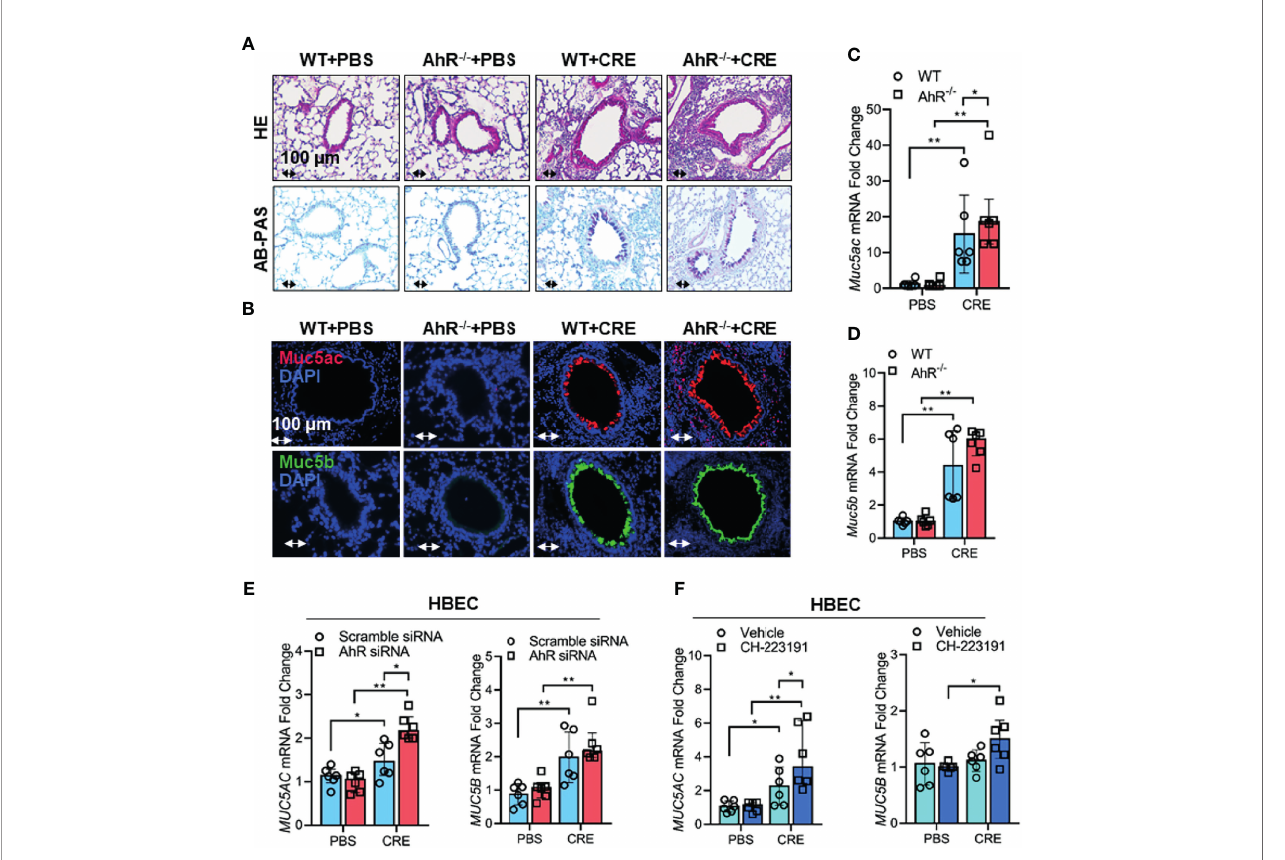
FIGURE 3 | Cockroach allergen-activated AhR protects airway in fl ammation and Muc5ac production. (A) Histological examination of mouse paraf fi n lung sections stained with hematoxylin and eosin (H&E, upper panel) and Alcian Blue periodic acid-Schiff (AB-PAS, lower panel). (B) Representative immuno fl uorescence images of Muc5ac (red) and Muc5B (green) in the lung tissues of cockroach allergen-induced mouse model with wild-type (WT) and AhR -/- mice (n = 6). (C, D) , RT-PCR analysis of Muc5ac (C) and Muc5B (D) in the lung tissues of cockroach allergen-induced mouse model (n = 6). (E) RT-PCR analysis of Muc5ac and Muc5B in cockroach extract (CRE, 50 µg/ml)-treated HBECs with or without AhR knockdown (n=6). (F) RT-PCR analysis of Muc5ac and Muc5B in CRE-treated HBECs with or without CH223191 (10 µM, n = 6). Data represent as medians with interquartile (IQR). * P < 0.05, ** P <